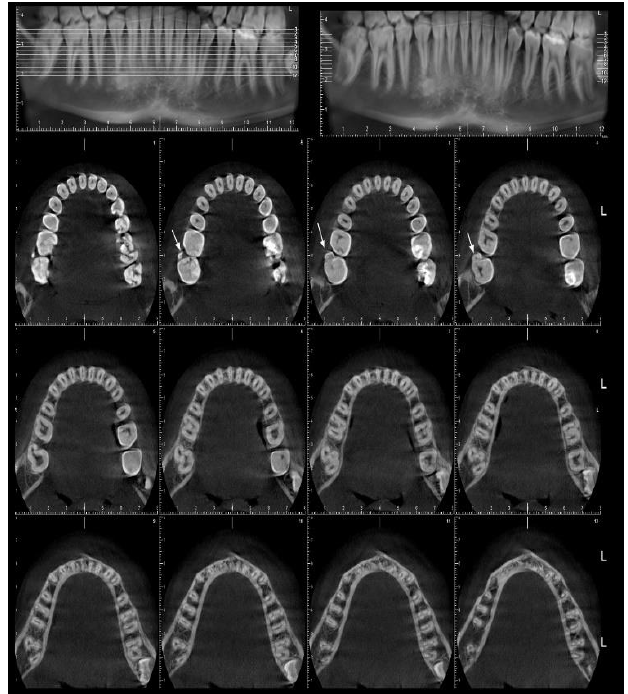
Fig. 1. Panoramic view showing missing of 22, 12 and 48 and an enlarged 47.